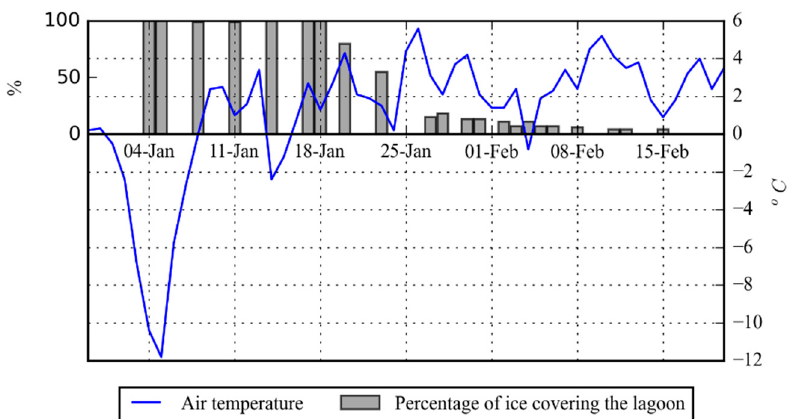
Figure 7. Variations of the average air temperature (blue line) and percentage of the ice cover (gray bars) in the Curonian Lagoon during the shortest winter season of 2007–2008.